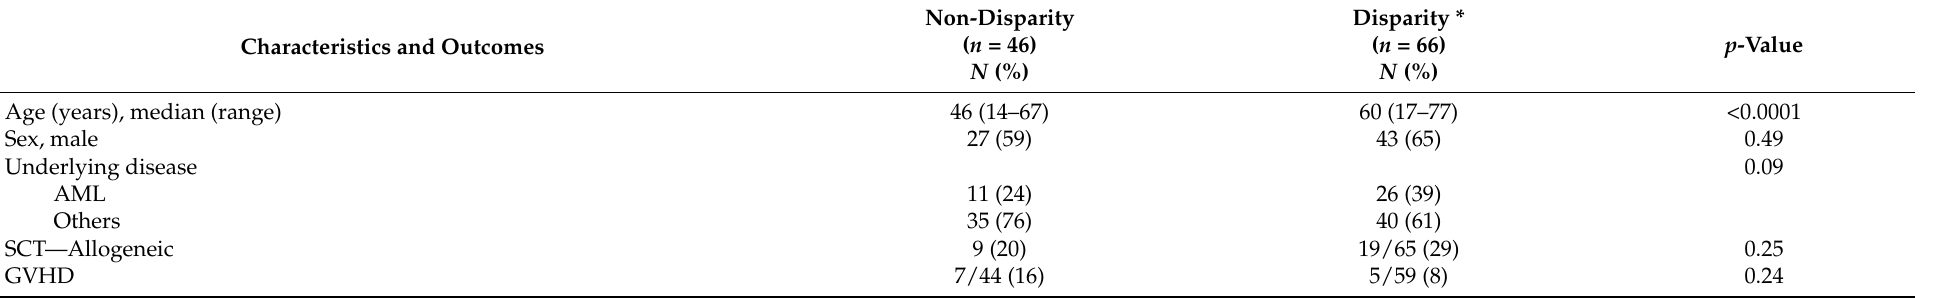
Table 3. Comparing patients with and without